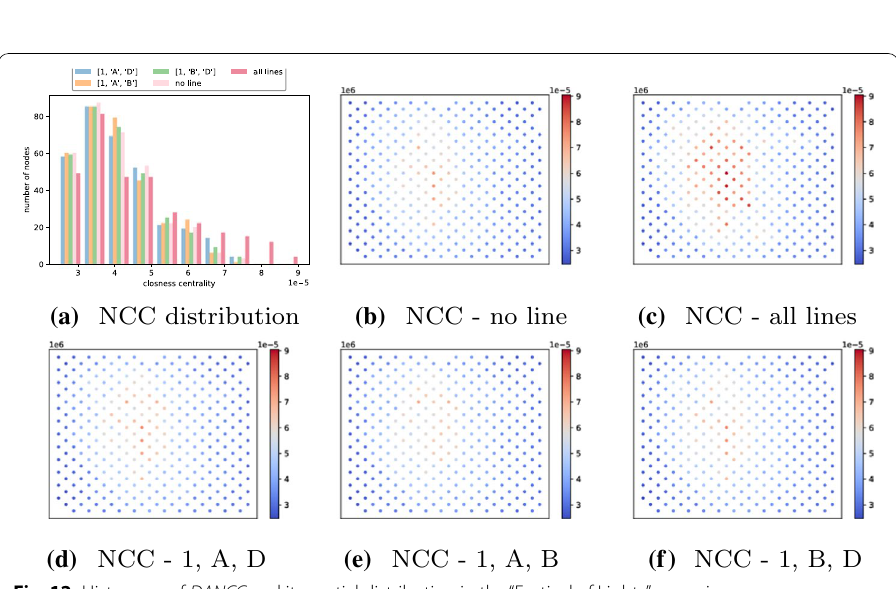
Cordeliers) and line D (e.g., Bellecour square) are the most impacted by the event. In